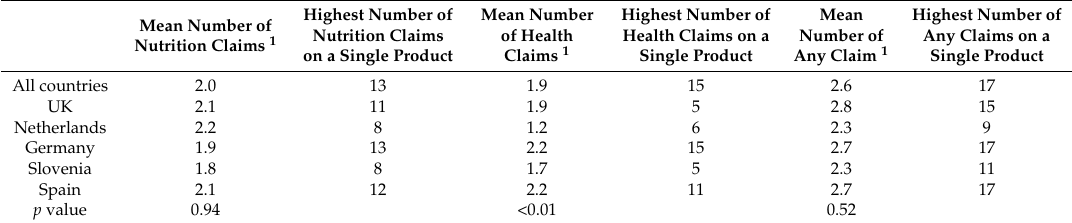
Table 3. Number of claims per